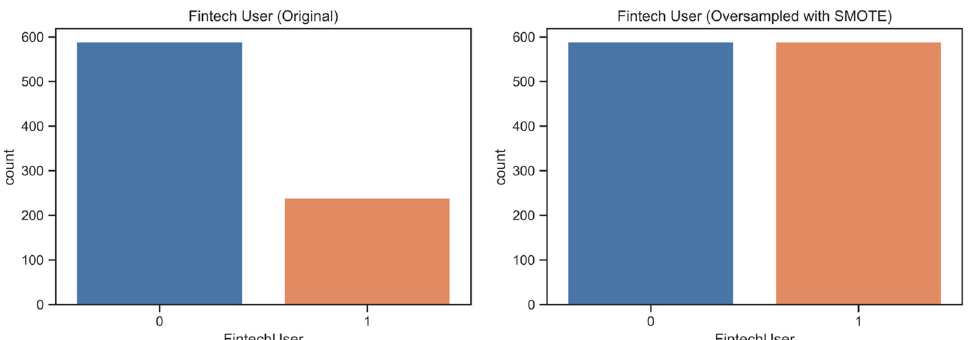
Figure 2. Distribution of fintech users and non-users in the original set after split ( left ) and distribution after SMOTE ( right ). Fintech users are denoted by “0” (in blue) and fintech users are denoted by “1” (in orange).